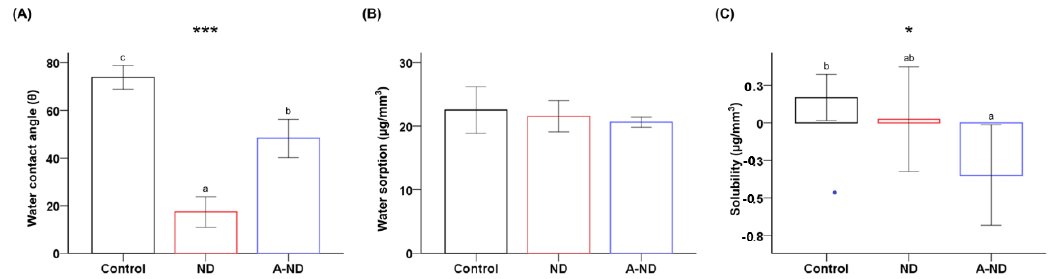
Figure 5. Comparing ( A ) water contact angles; ( B ) water sorptions; and ( C ) solubilities of the control, ND-, and A-ND-incorporated groups. The same lowercase letters indicate no significant di ff erence. * p < 0.05, *** p < 0.001.